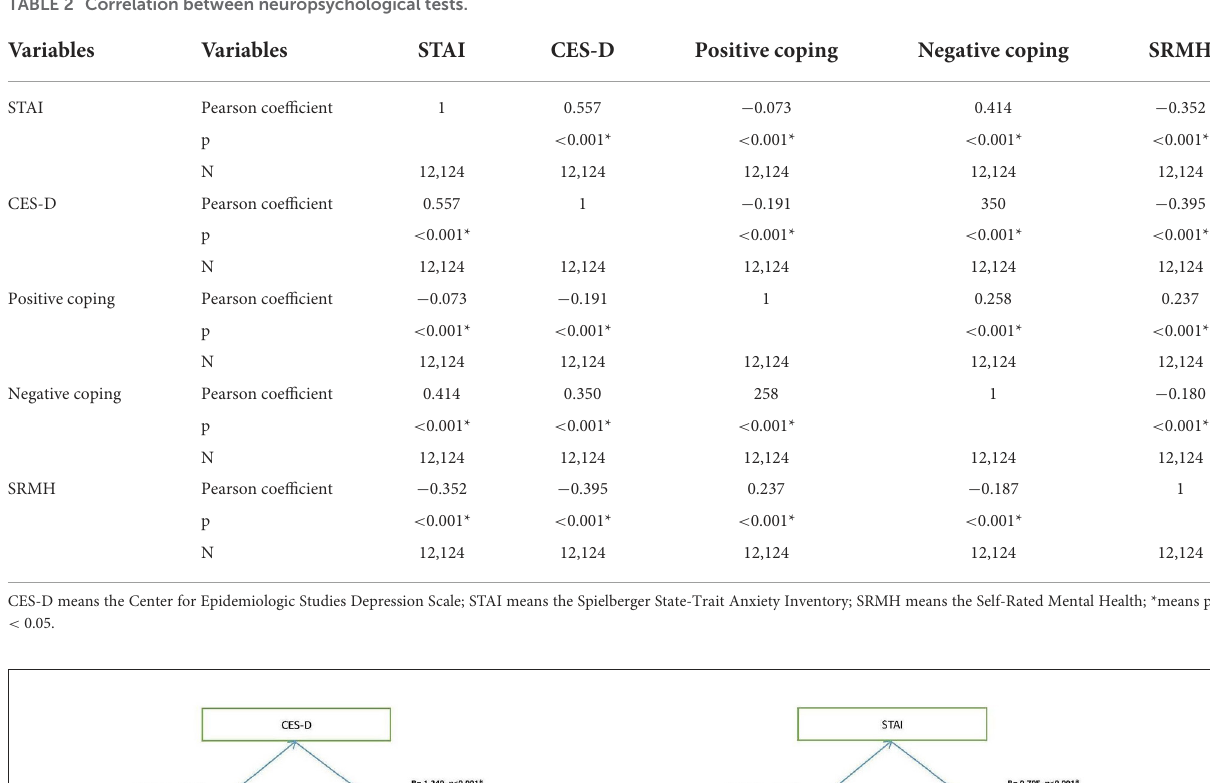
TABLE 2 Correlation between neuropsychological tests.